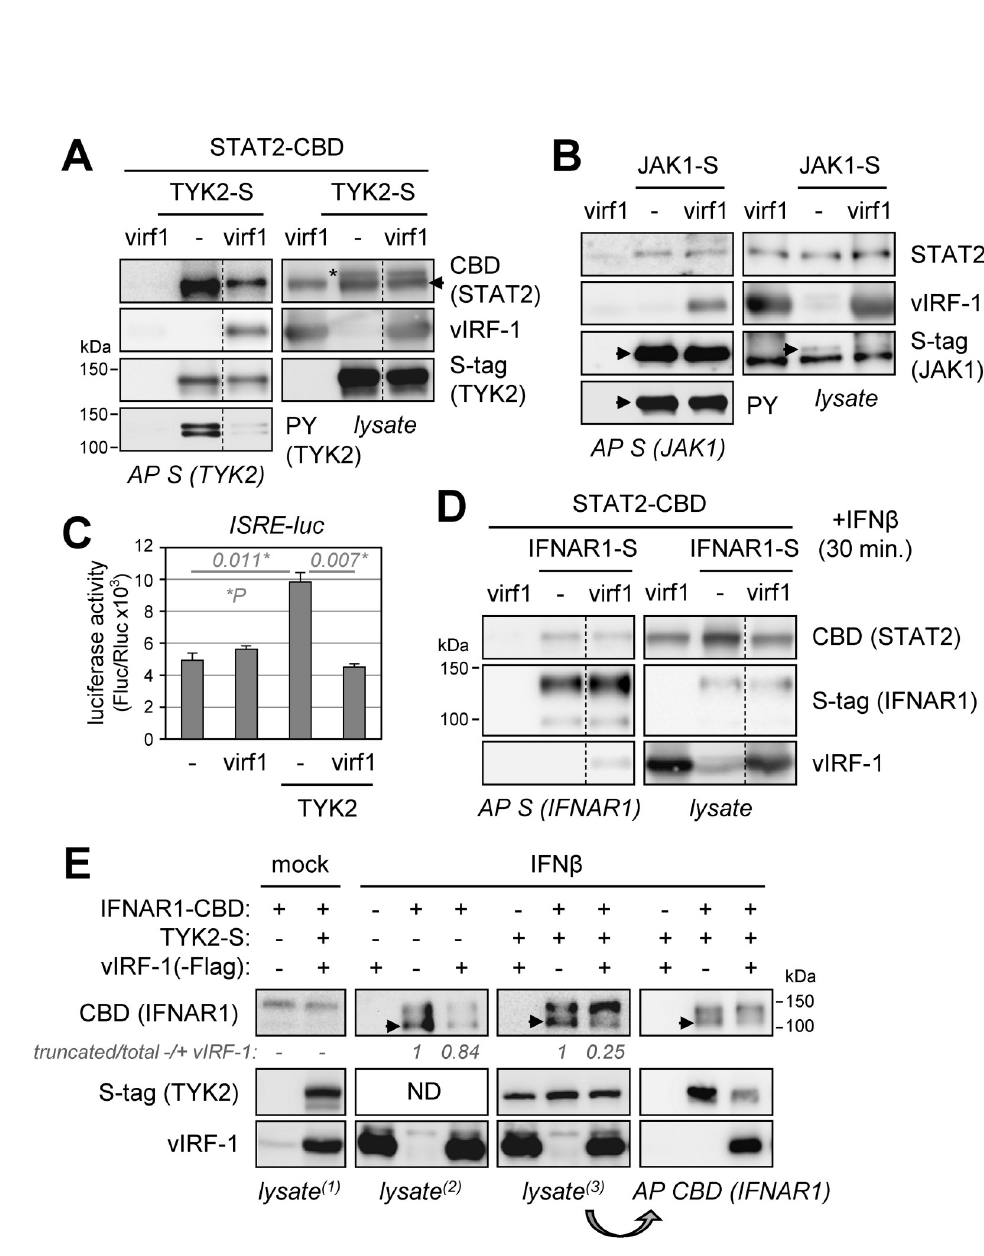
Fig 6. Physical and functional interactions of vIRF-1 with JAKs. (A) TYK2-S and STAT2-CBD were expressed with (virf1) or without (-) vIRF-1 in transfected 293T cells. Cell lysates and S-protein affinity-precipitates were assessed for input protein expression and sedimentation by immunoblotting with CBD (STAT2), vIRF-1, and S-tag (TYK2) antibodies. Affinity-precipitated TYK-2-S was probed with phospho-tyrosine (PY)-specific antibody to identify the active, autophosphorylated form of the kinase. Dotted lines indicate lane deletions from single membranes; the arrowhead and asterisk indicate CBD-specific (STAT2) band and remnant S-tag signal (after blot stripping), respectively. (B) An equivalent experiment was performed to assess vIRF-1 effects on JAK1 autophosphorylation and association with STAT2. Here, STAT2 antibody was used to detect endogenous protein. Arrowheads indicate JAK1-S (~130 kDa). (C) ISRE- luciferase reporter assay to assess vIRF-1 inhibition of TYK2-mediated signal transduction in 293T cells cotransfected with TYK2-expression and reporter plasmids and either vIRF-1 (virf1) or empty (-) expression vectors. Average values from duplicate samples for each condition are shown; error bars indicate standard deviations from the means. Statistical significance (P) was determined by student t-test (two-tailed, unpaired). (D) IFNAR1-S-based coprecipitation assay to test the influence of vIRF-1 (virf1), relative to empty-vector (-) transfection, on STAT2-receptor association, following IFN